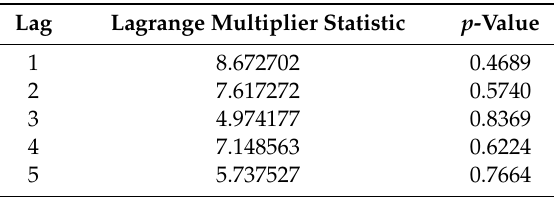
Table 5. Residual serial correlation LM